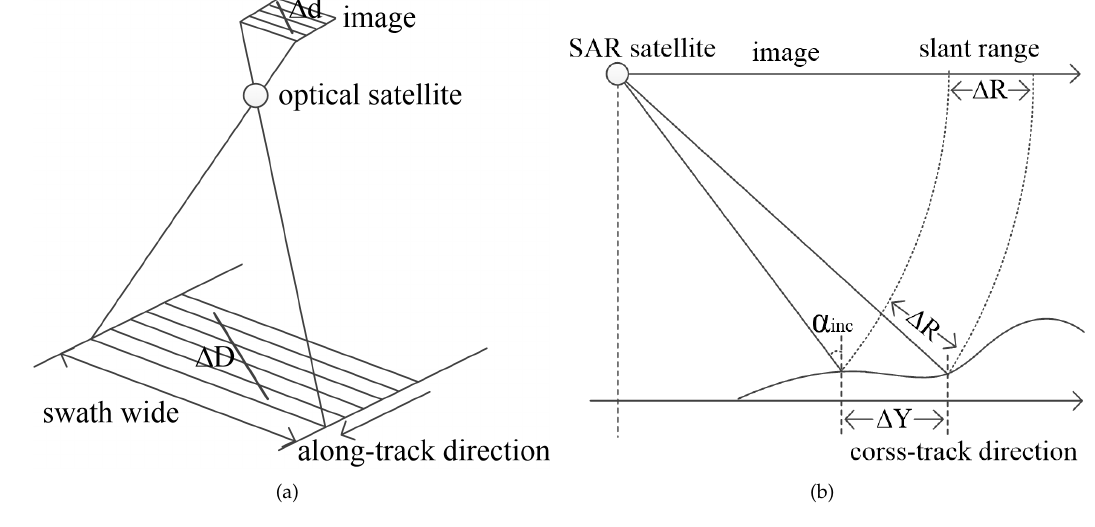
Figure 1. The imaging mechanism of optical and SAR satellite: ( a ) the central projection of optical satellite. ( b ) The slant range projection of SAR